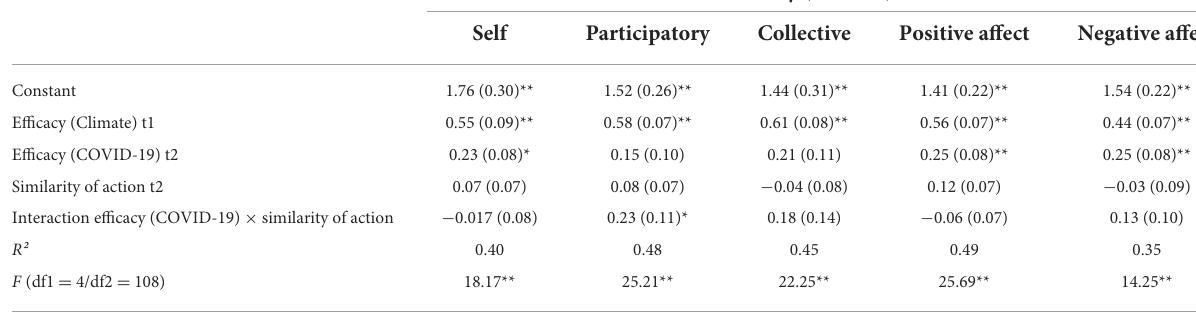
TABLE 4 Model coefficients for moderation models assuming a moderating effect of perceived similarity of action on the transfer of COVID-19-related efficacy beliefs on climate-related efficacy beliefs.